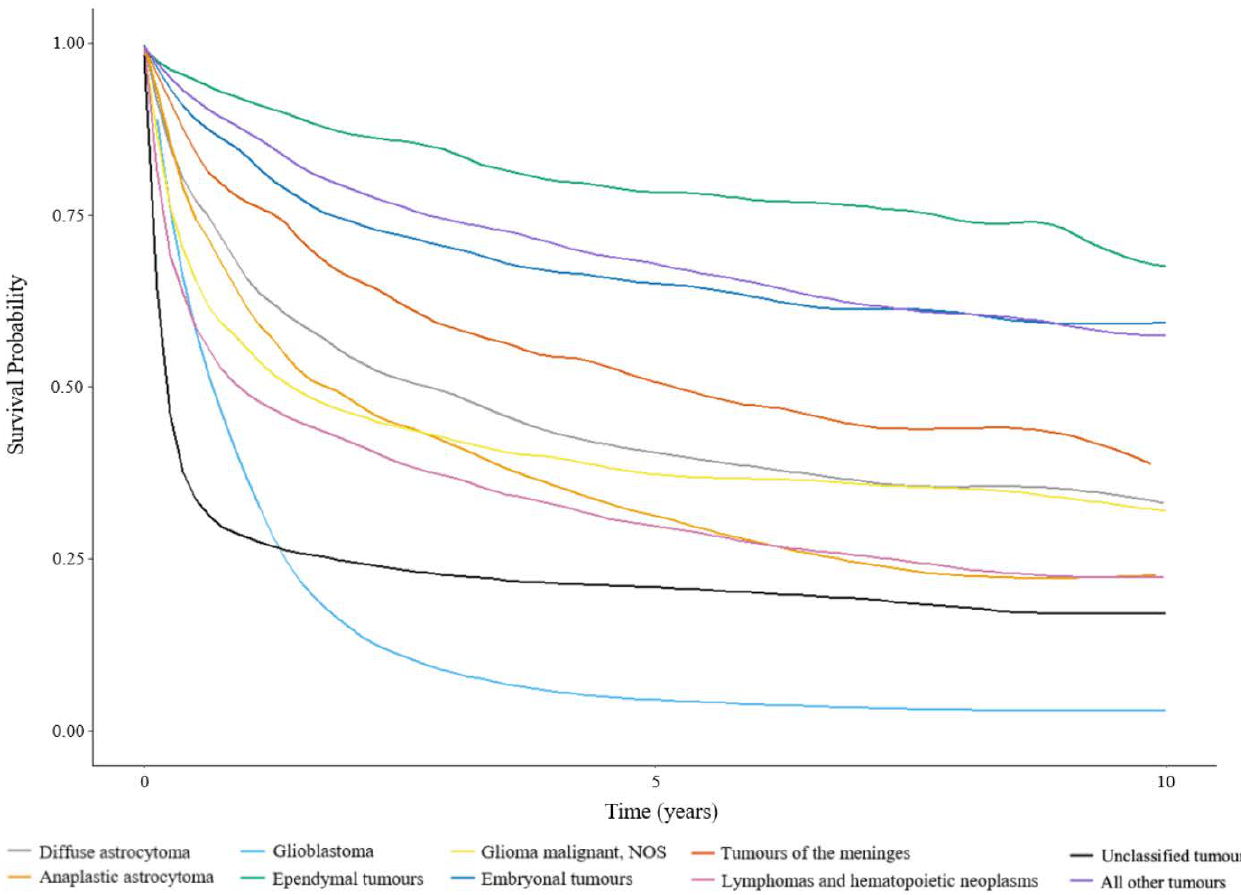
Figure 3. Kaplan–Meier survival curves for primary malignant CNS tumour patients diagnosed between 2008 and 2017 in Canada (excluding Quebec) stratified by selected histology. “All other tumours” include the following: pilocytic astrocytoma, unique astrocytoma variants, oligodendroglioma, anaplastic oligodendroglioma, oligoastrocytic tumours, choroid plexus tumours, neuronal and mixed neuronal-glial tumours, tumours of the cranial and spinal nerves, germ cell tumours, cysts and heterotopias, tumours of the sellar region.